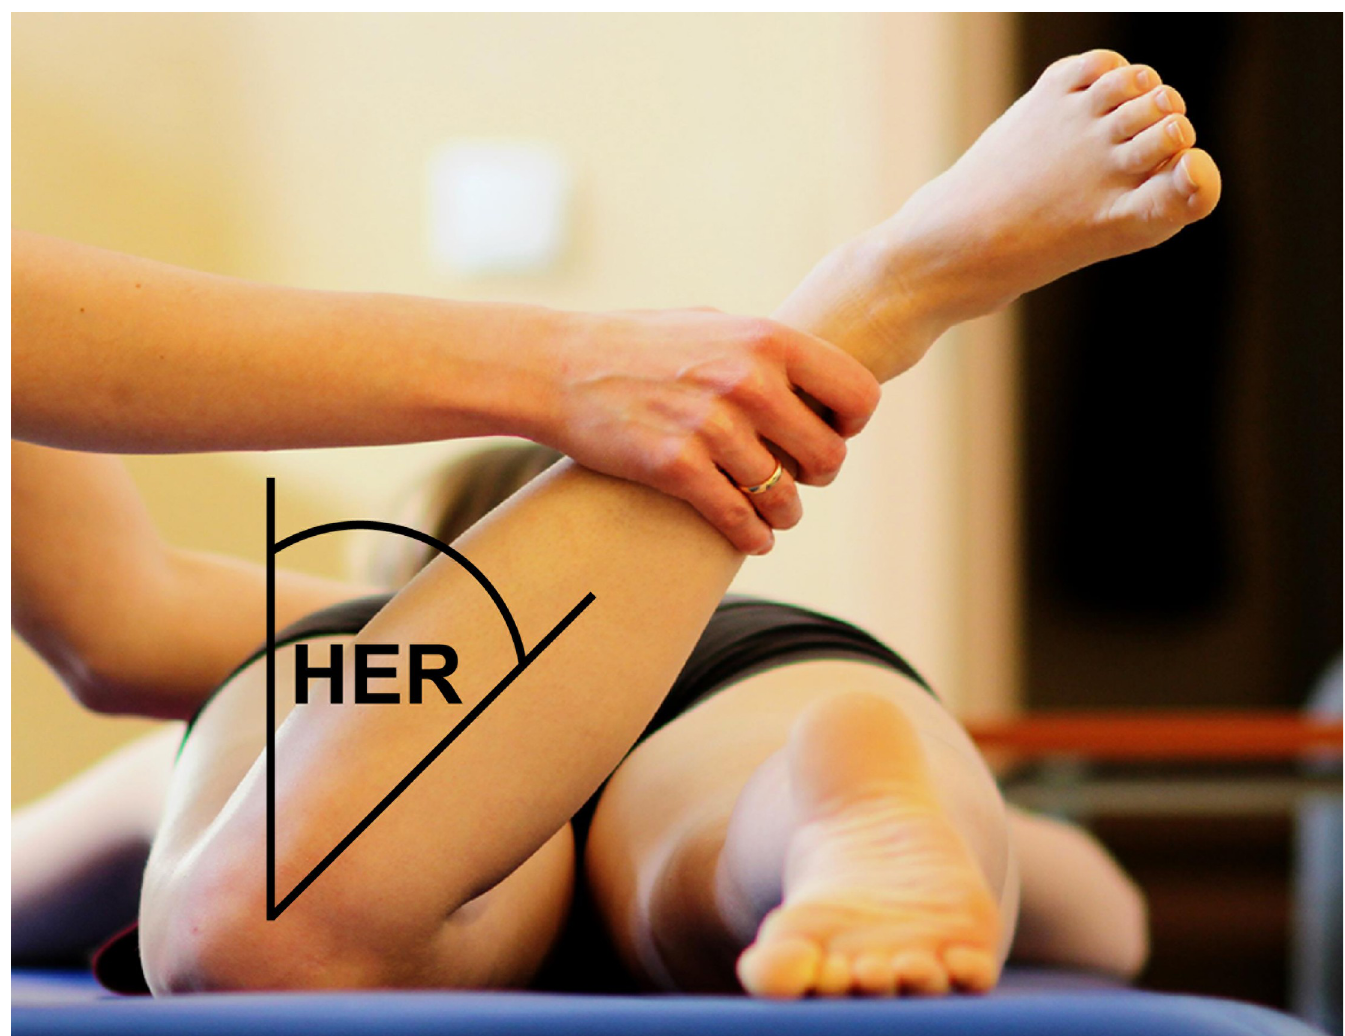
Fig 1. The picture of the position for the passive hip external rotation (HER)